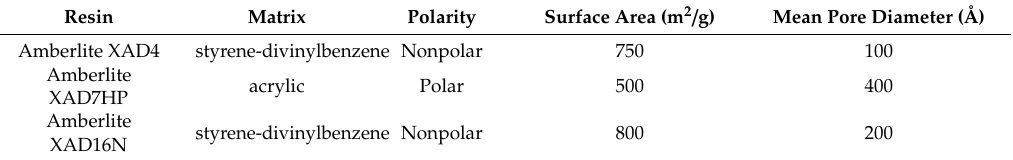
Table 3. Physical properties of the adsorption resins used for LP (lemon pigment) purification.